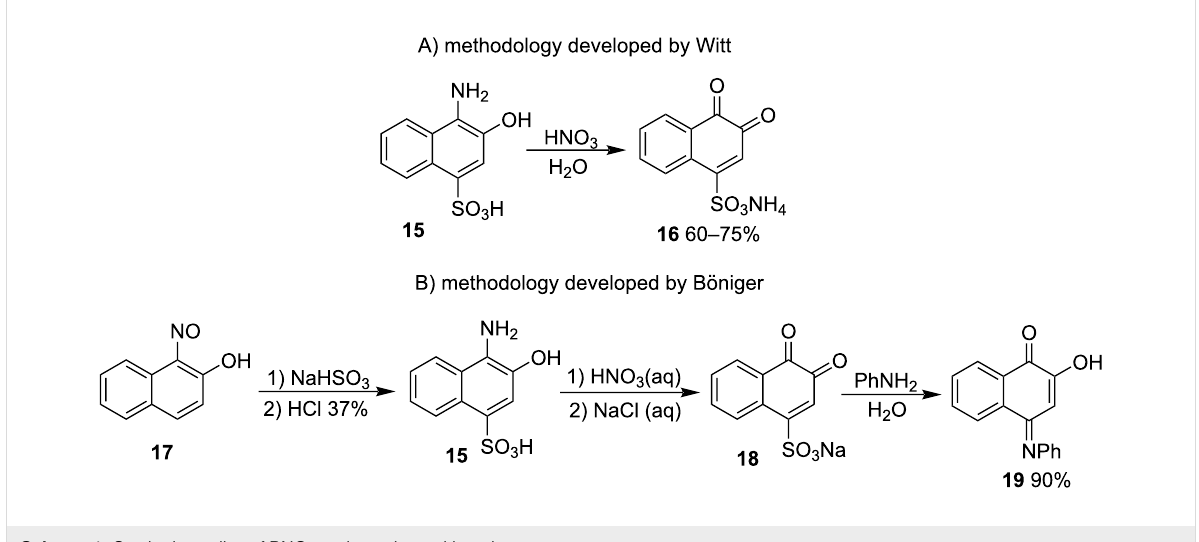
Scheme 1: Synthetic studies of BNQs and reactions with